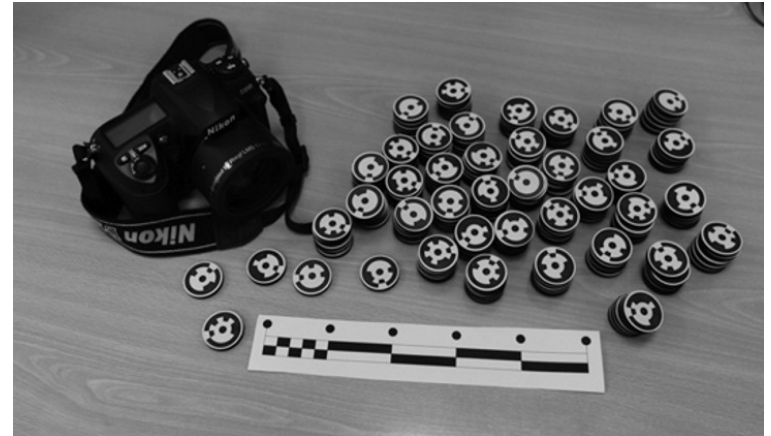
Figure 2. Indirect measurement equipment: digital camera, coded targets and scale